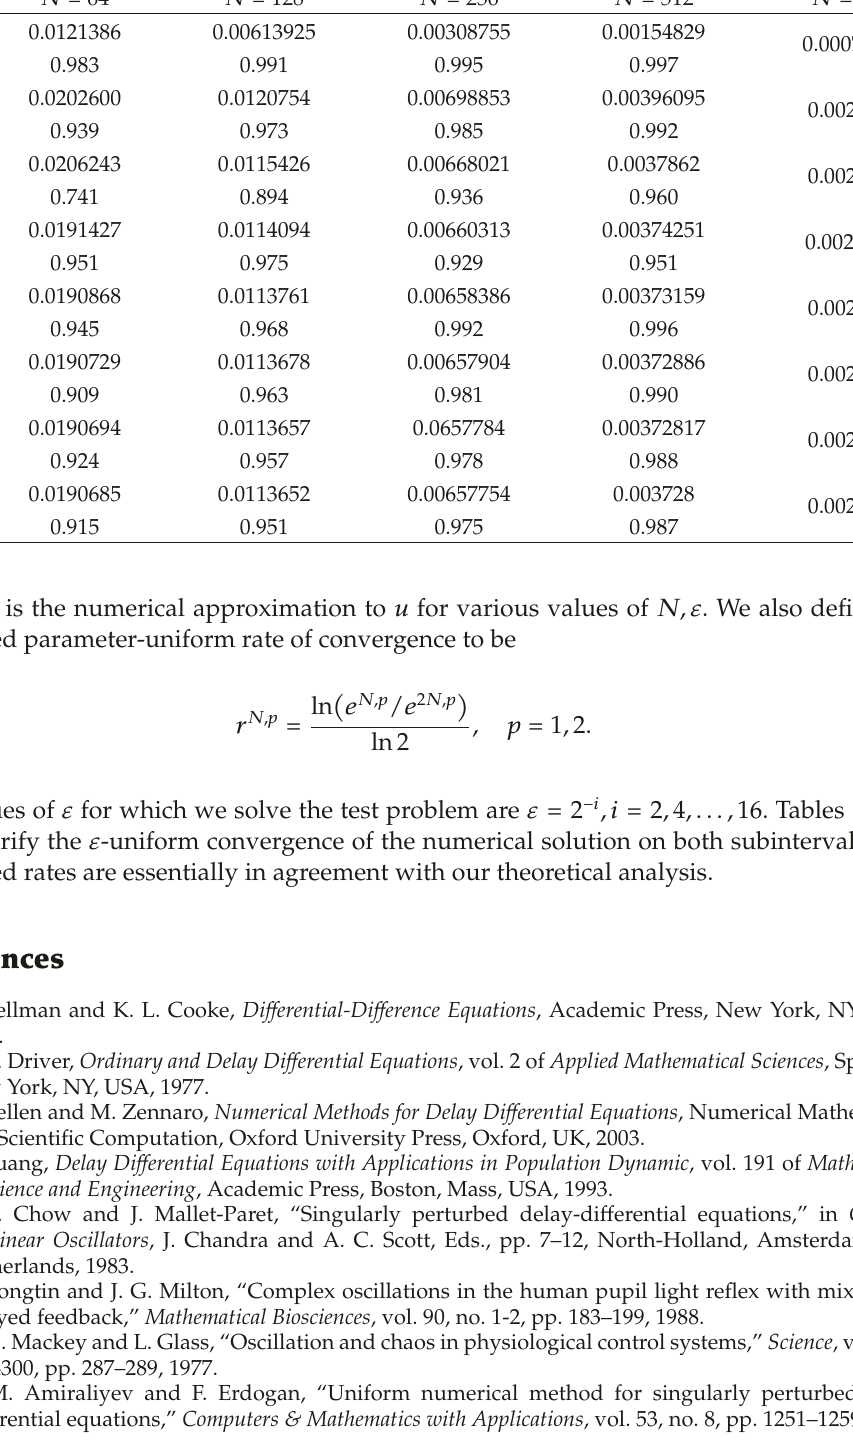
Table 4: Maximum Errors and Rates of Convergence for the Bakhvalov Mesh on ω